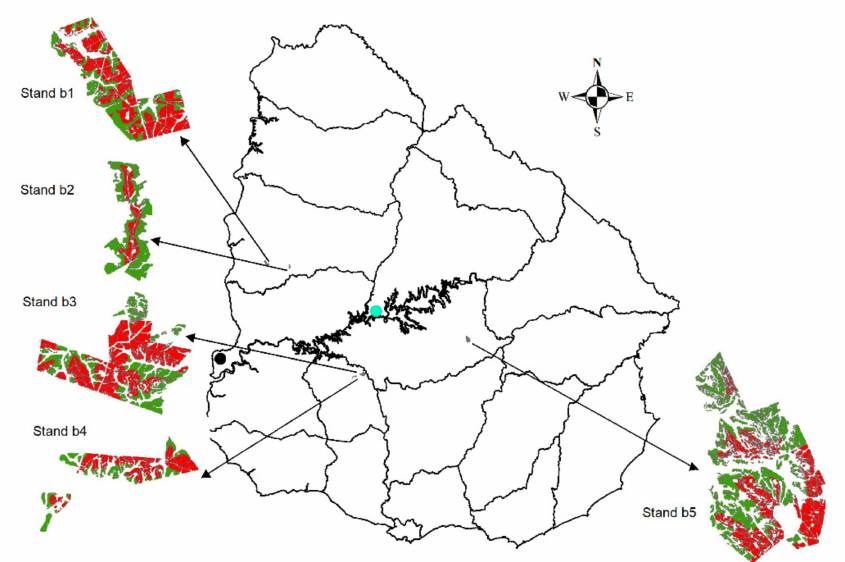
Figure 1. Location of the study sites: b1 and b2 (Guichon); b3 and b4 (Trinidad); and zone b5 (Sarand í del Yi) in Uruguay. In green, E. grandis stands, in red, E. dunnii stands; circle in cyan: pulp mill Fray Bentos ( − 33.12148; − 58.25455), circle in black: pulp mill Paso de Los Toros ( − 32.83006; − 56.49728, approx. building under